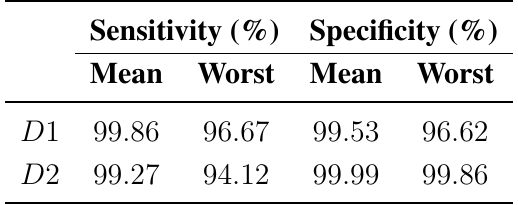
Table 4. Accuracy of the proposed outlier detection